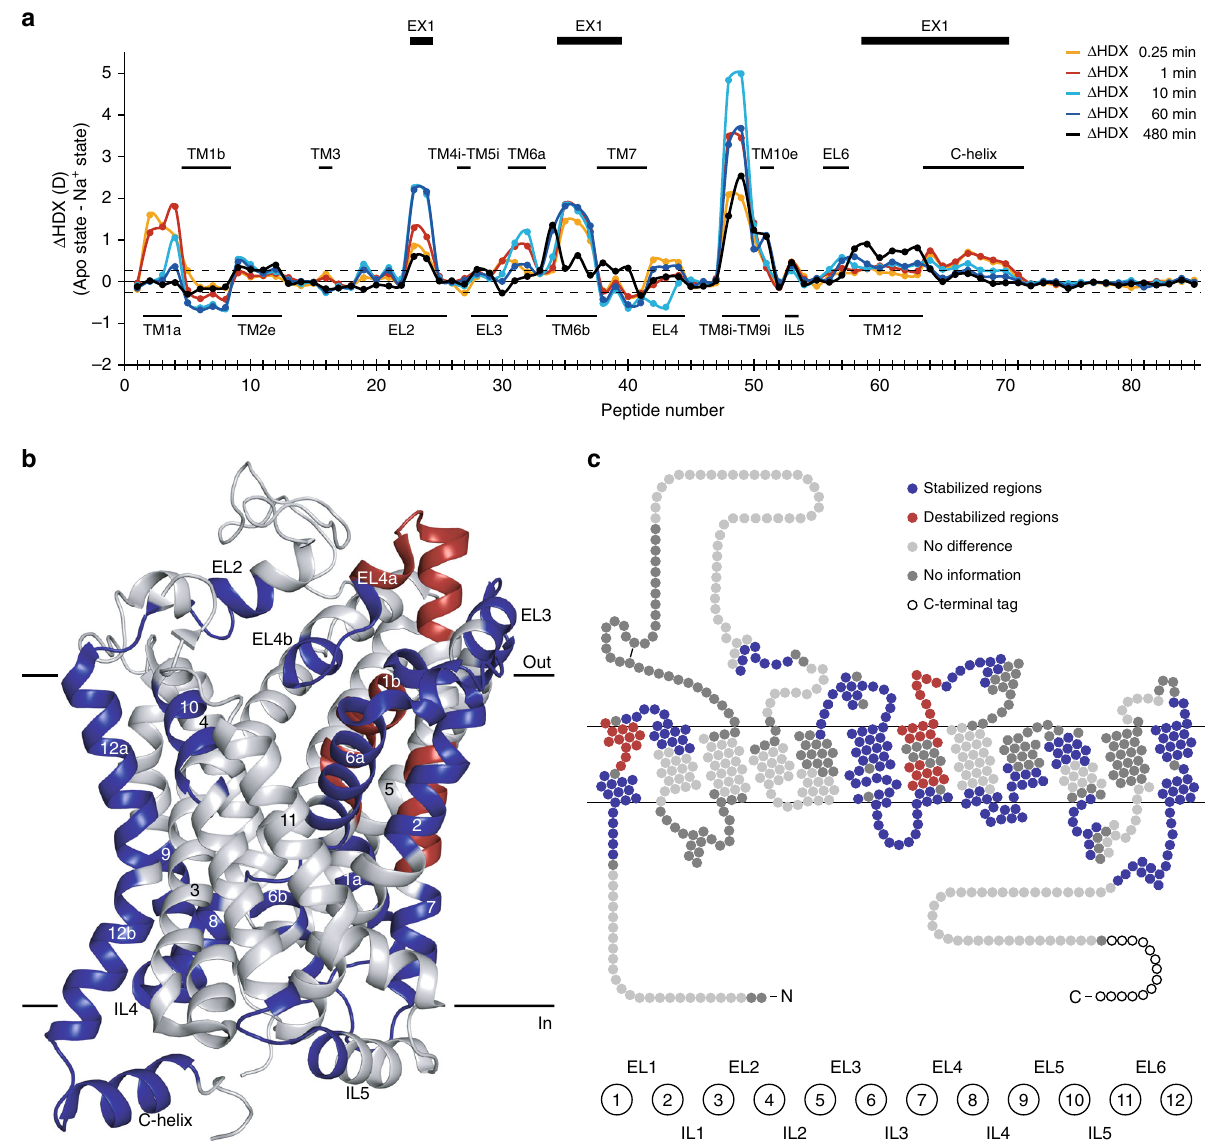
Fig. 3 Effect on local HDX upon ion binding to dDAT. a Chart showing differences in the average deuterium uptake ( Δ HDX) between the apo state and the Na + -bound state for the 85 identi fi ed peptides at the fi ve sampled time points (orange — 0.25 min; red — 1 min; cyan — 10 min; blue — 1 h; black — 8 h). The individual dDAT peptides are arranged along the x-axis starting from the N-terminal and ending on the C-terminal. The peptide number refers to Supplementary Table 2. Positive and negative values indicate reduced and increased HDX, respectively, upon binding of Na + . Values represent means of either three (apo state) or six (Na + state) independent measurements. Structural motifs in dDAT are marked along the x -axis together with regions showing correlated exchange kinetics (EX1) in at least one of the two states. The dotted lines (±0.26 D) mark a threshold value for signi fi cant differences in HDX corresponding to the 95% con fi dence interval, calculated from the pooled standard deviations for all time points. b , c Regions showing signi fi cant differences (Student ’ s t -test p -value < 0.01) in deuterium uptake between the apo state and the Na + -bound state for at least two consecutive time points are mapped onto the crystal structure ( b ) (PDB ID: 4XP1) and snake diagram ( c ) of dDAT. Regions are colored red and blue to indicate dDAT segments becoming destabilized (increased HDX) or stabilized (decreased HDX), respectively, upon binding of Na + . Regions colored light grey displayed unchanged HDX while regions in dark gray were uncovered by peptide sequences. Wild-type dDAT regions including part of EL2 (residue 162 – 202) and the N- and C- termini (residue 1 – 24 and 601 – 645, respectively) are only marked on the snake diagram in c as they were not resolved in the crystal structure ( b ) or were truncated in the construct used for crystallization. Source data are provided as a Source Data fi